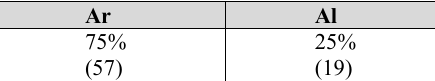
Tableau .2: Nature des